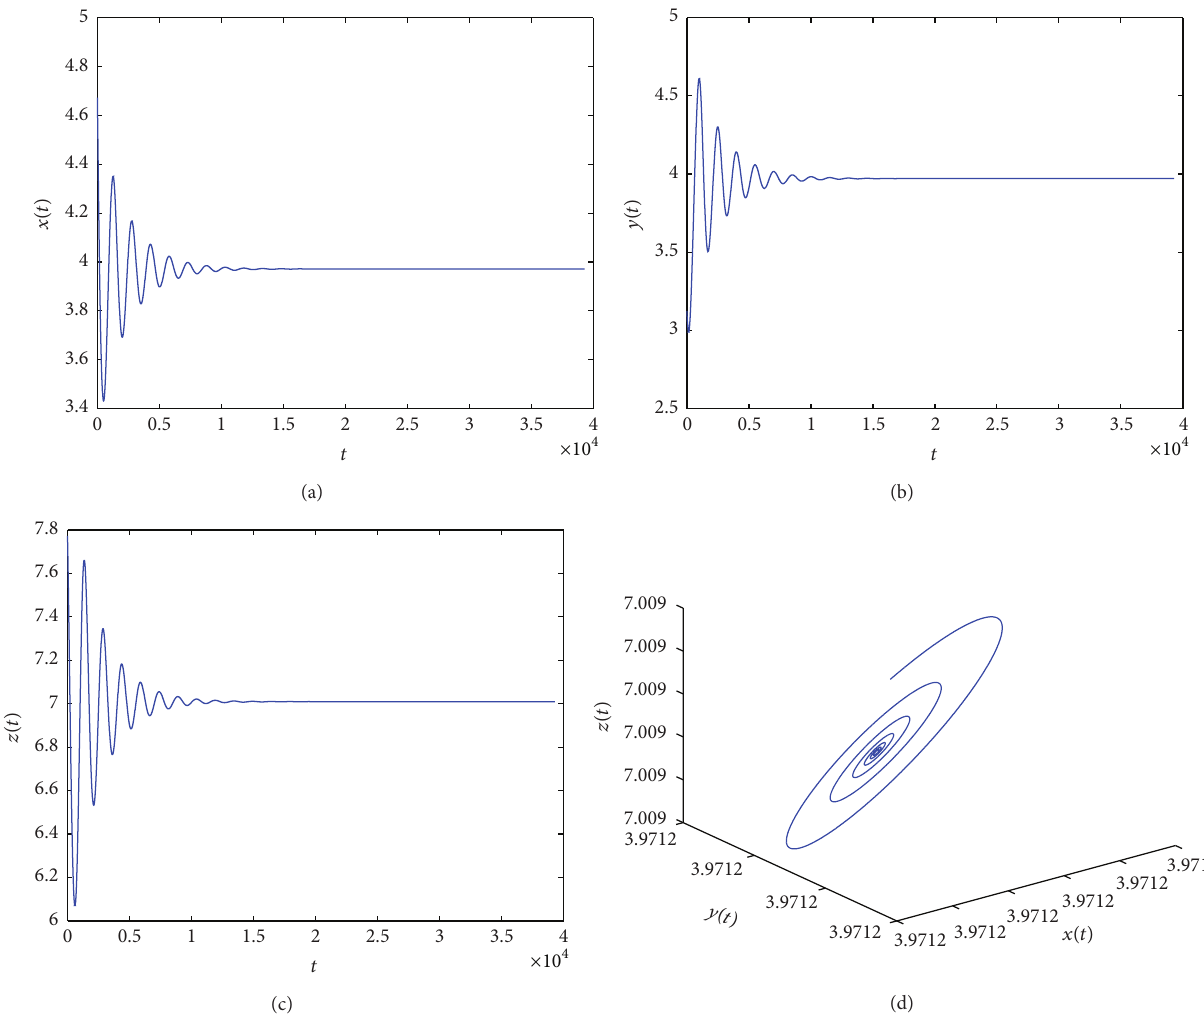
Figure 1: The trajectories and the phase graph of system (83) with 𝑇 = 98 , 𝜀 = 0 , and 𝜏 = 0.2 ; 𝐸 ∗ 2 is asymptotically stable.